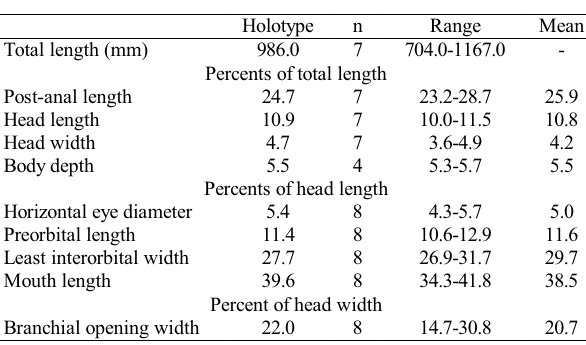
Table 1 . Morphometric data for Synbranchus lampreia , MZUSP 50184, holotype, MZUSP 50185 (n = 4), MPEG 3374 (n = 1), MPEG 3377 (n = 1), and MPEG 3379 (n=